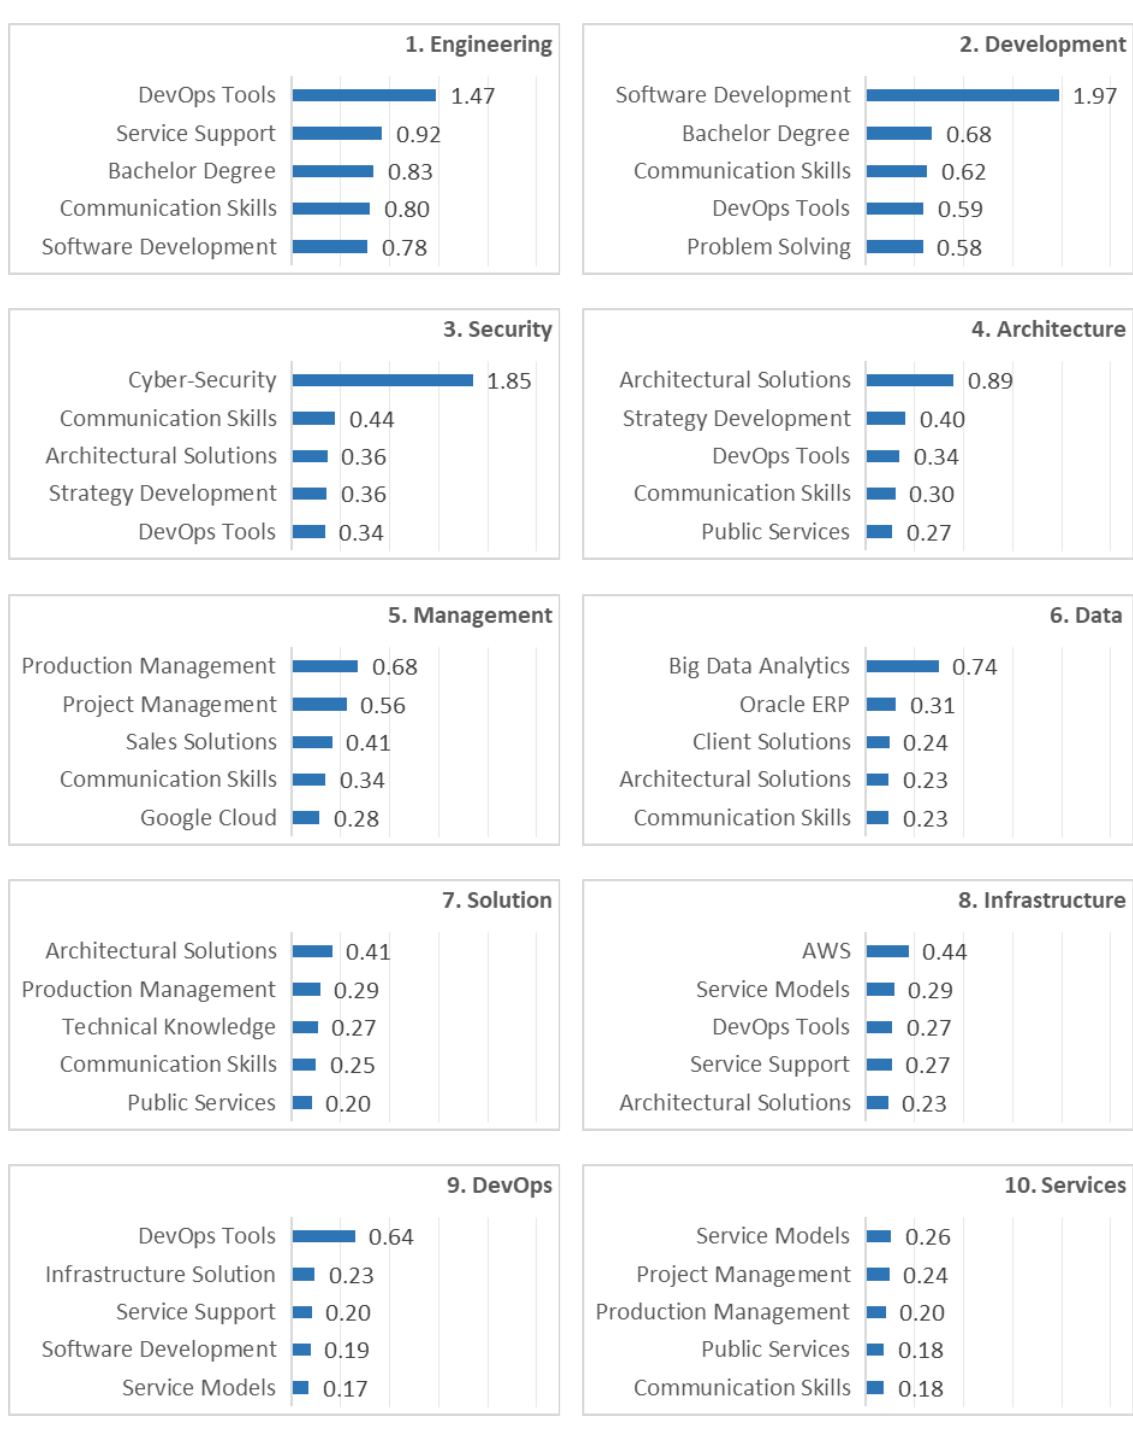
Figure 2. Percentage charts of the top five skills in the top 10 competency areas.